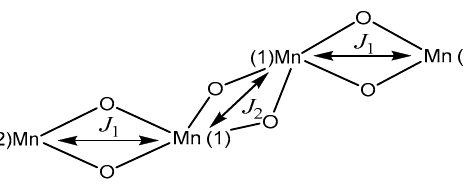
Figure 9. Structural arrangement for [M 4 O 6 ] and the exchange magnetic constant of 1 .